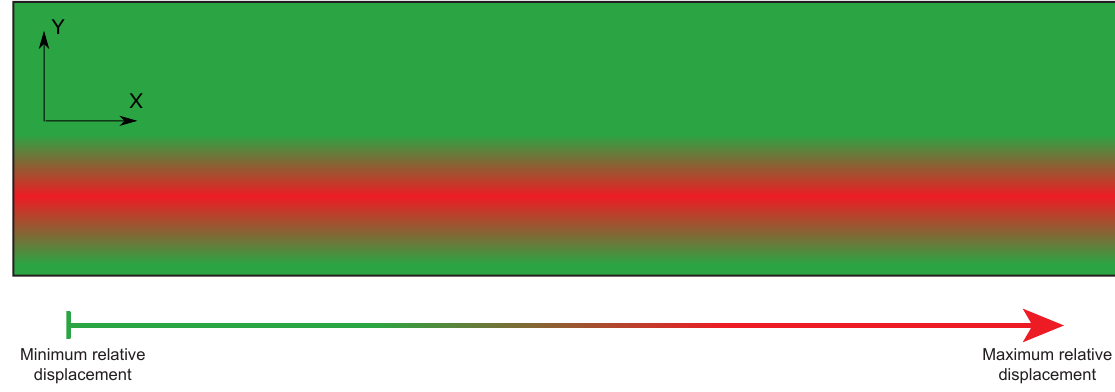
Figure 7. Top blade-strip contact patch view: high mobility region (red) with the largest relative